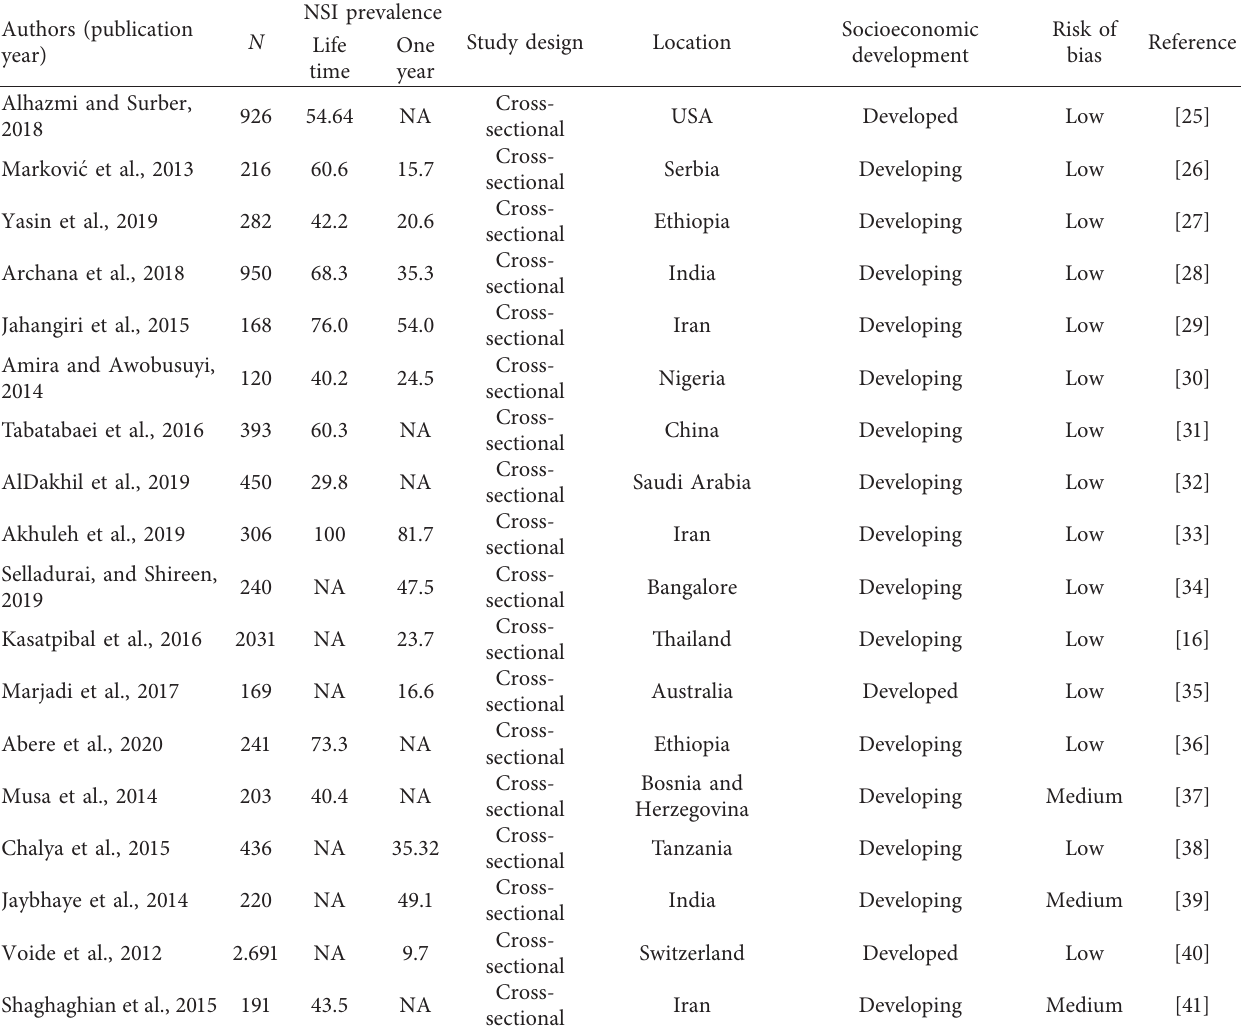
Table 1: Overall characteristics of included articles in the systematic review and